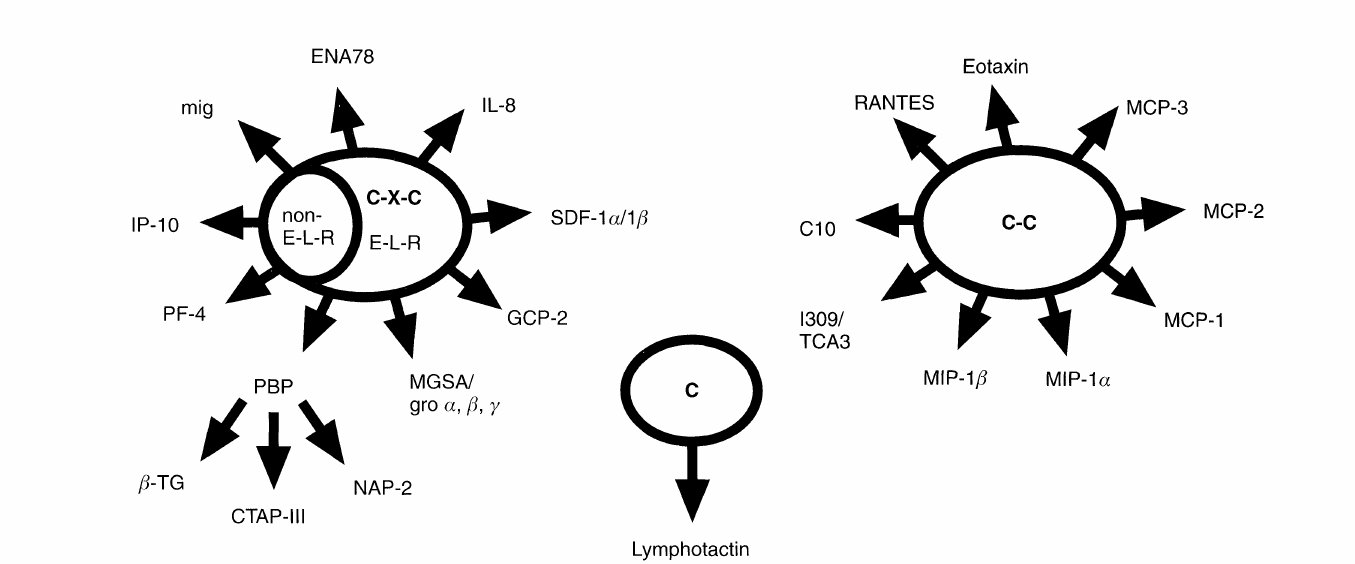
FIG. 2. Organization of the chemokine superfamily. Schematic depiction of a four-part superfamily structure, on the basis of the arrangement of amino acids around the conserved cyststeines in the proteins. The name used for each of the chemokines is that of the human protein, other names for homologues from other species may exist. The arrows originating from PBP indicate that three proteins with distinct activities (-TG, CATP-III, and NAP-2) are proteolytically derived from that molecule.